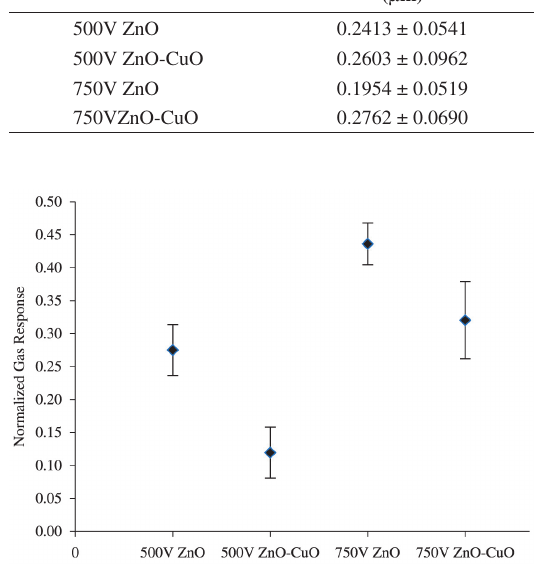
sensitivity of the ZnO and Zno-CuO 3